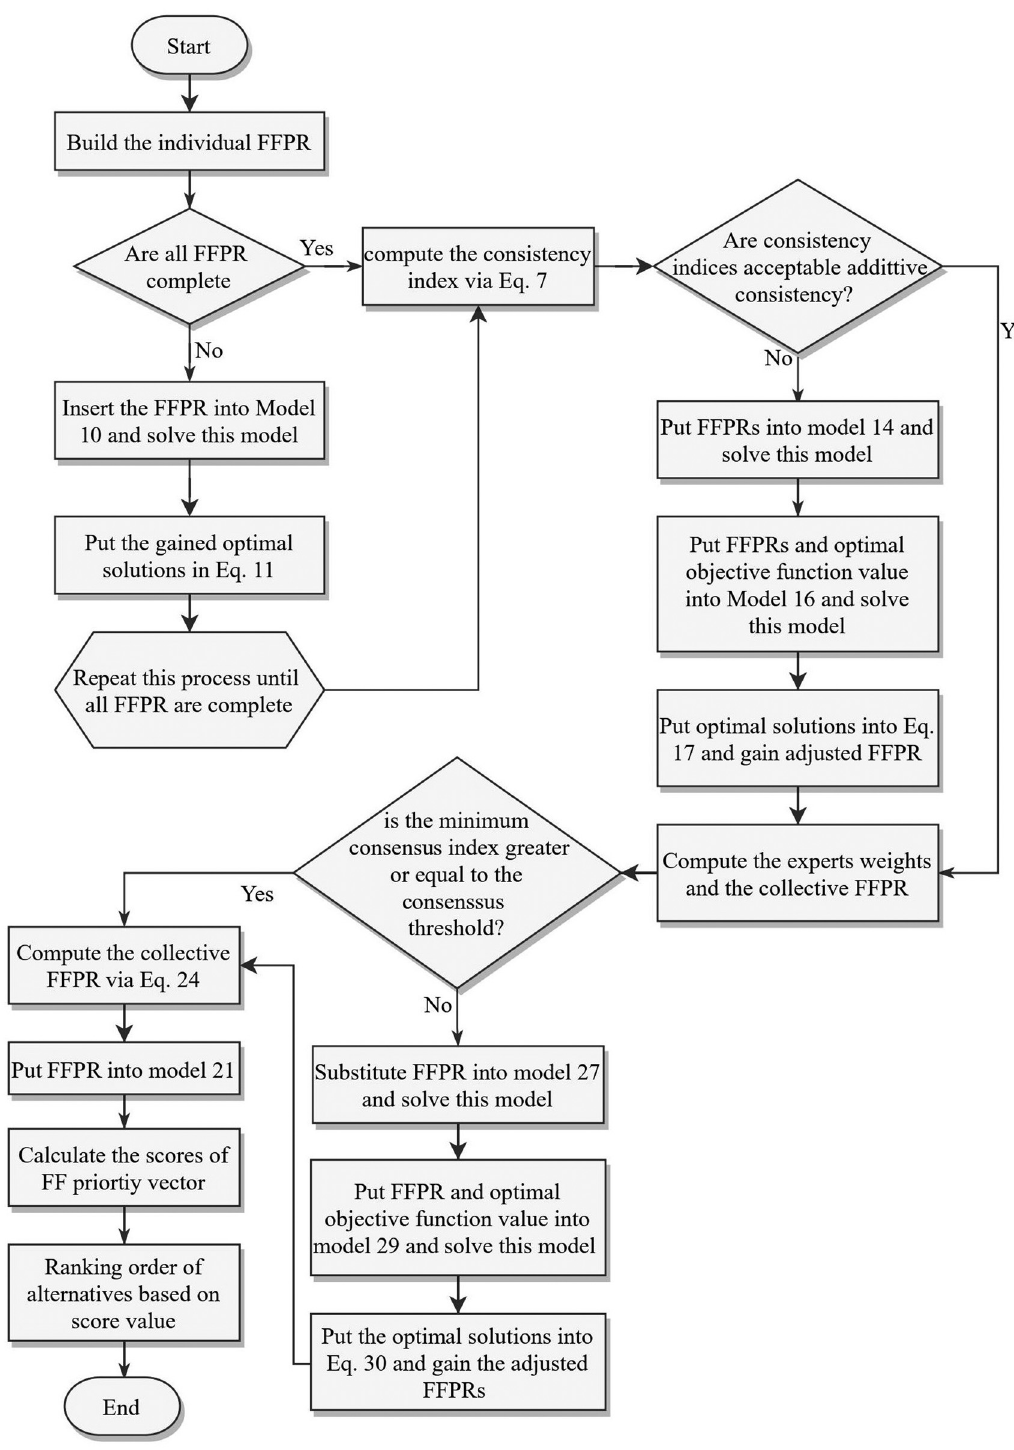
Figure 1: Flow charts for